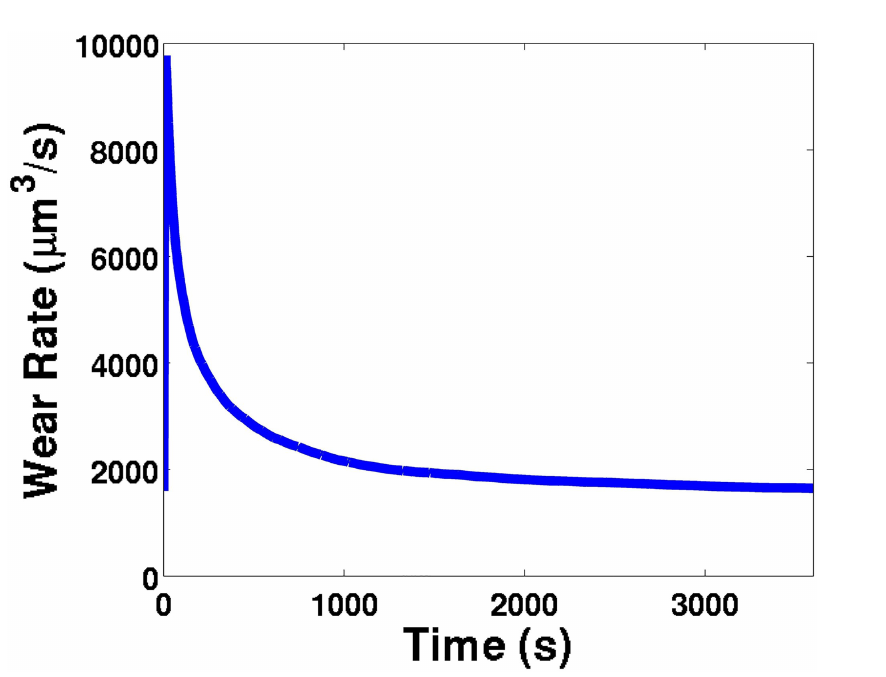
Fig 10. The phenomenon of running in, demonstrated from the numerical wear rate ( μ m 3 /s) simulation results for neat mineral oil at a bulk lubricant temperatureT = 59˚C.